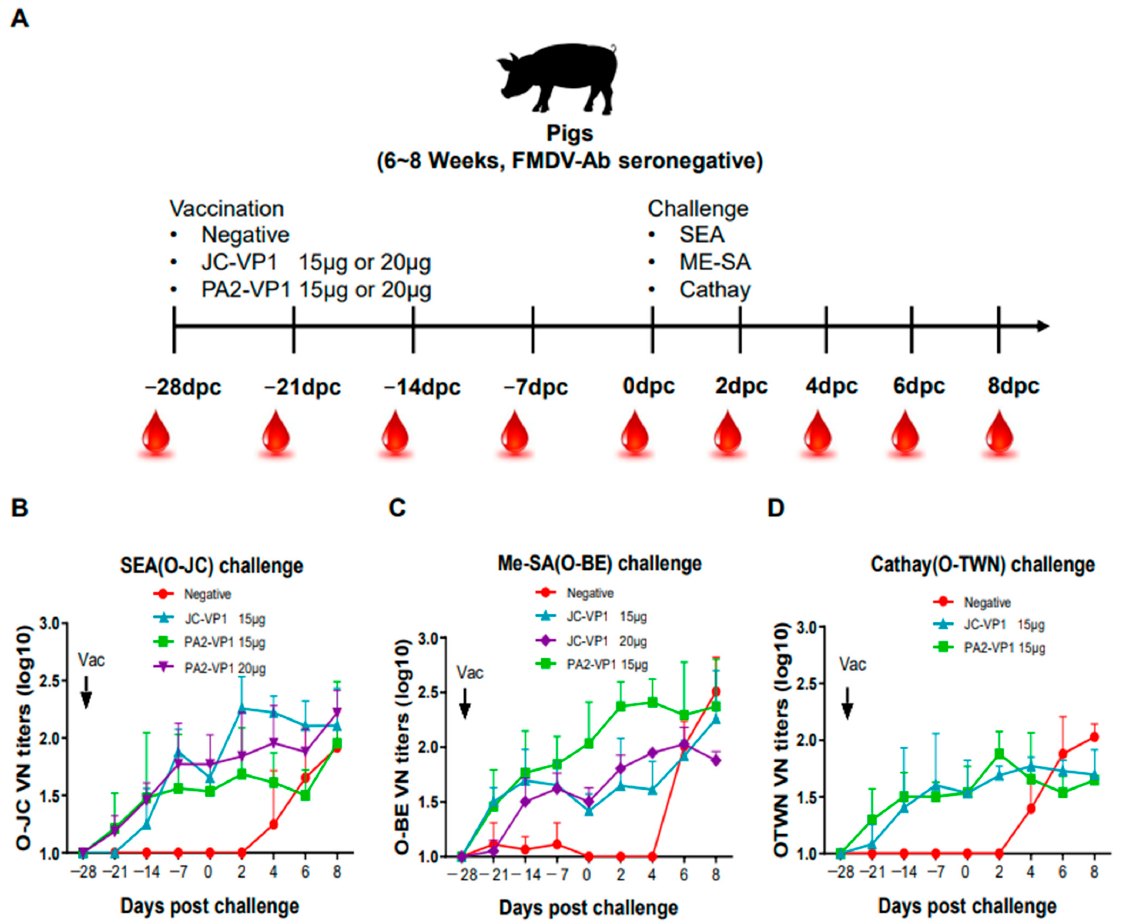
Figure 3. Variation in neutralizing antibody titers in pigs immunized with experimental vaccines. The pigs were inoculated with a second vaccination (15 μ g/dose of inactivated antigen mixed with ISA 206, saponin, and aluminum hydroxide gel adjuvant) at 28 dpv. Schematic diagram of study strategy ( A ). The pigs were challenged with the virus of SEA (O-JC) topotype ( B ), ME-SA (O-BE) topotype ( C ), and Cathay (O-TWN) topotype ( D ) after vaccination with either JC-VP1 or PA2-VP1. In the case of PA2-VP1, different doses of 15 μ g or 20 μ g against the SEA topotype virus were evaluated. In the case of JC-VP1, different doses of 15 μ g or 20 μ g against the ME-SA topotype virus were evaluated.